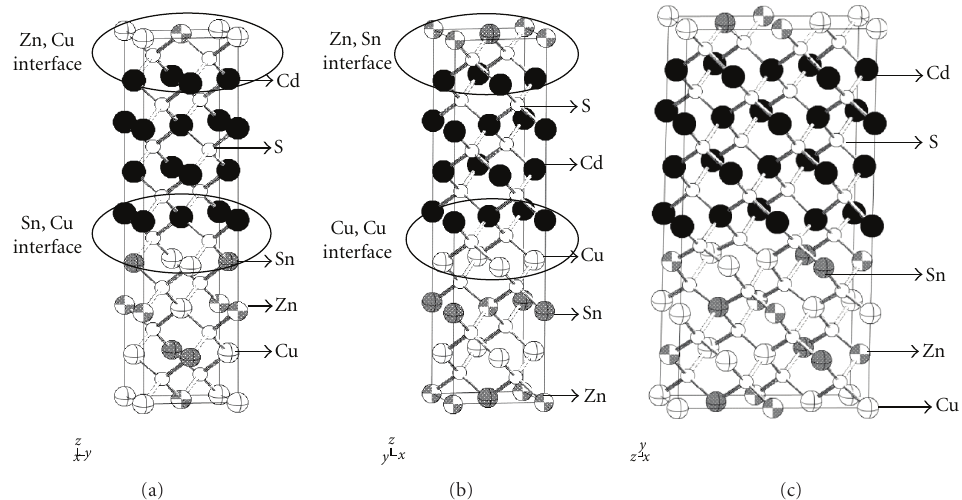
Figure 1: (a) Supercell of (001)-oriented CdS/kesterite-CZTS. (b) Supercell of (001)-oriented CdS/stannite-CZTS. (c) Supercell of (010)- oriented